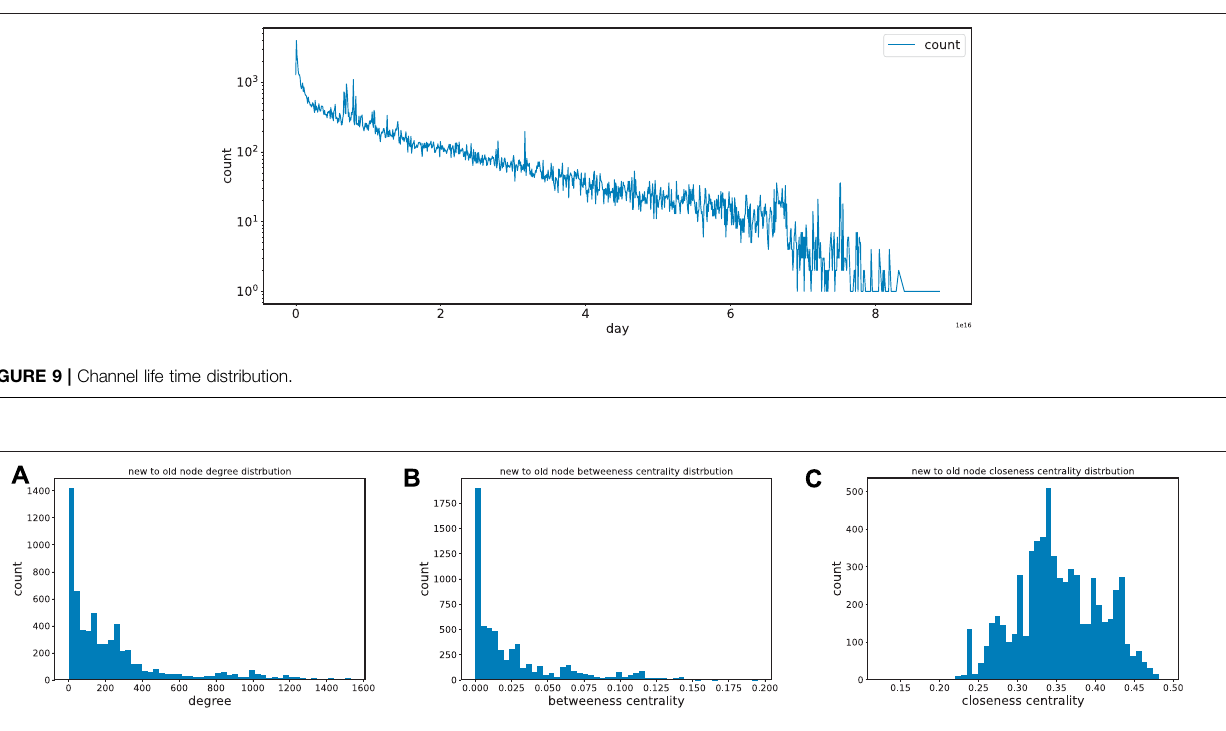
FIGURE10|(A) .Distributionofthedegreesofthenodesconnectedbythenewlyaddednodes (B) .Distributionoftheclosenesscentralityofthenodesconnected by the newly added nodes. (C) . Distribution of Betweenness Centrality of the nodes connected by the newly added nodes.